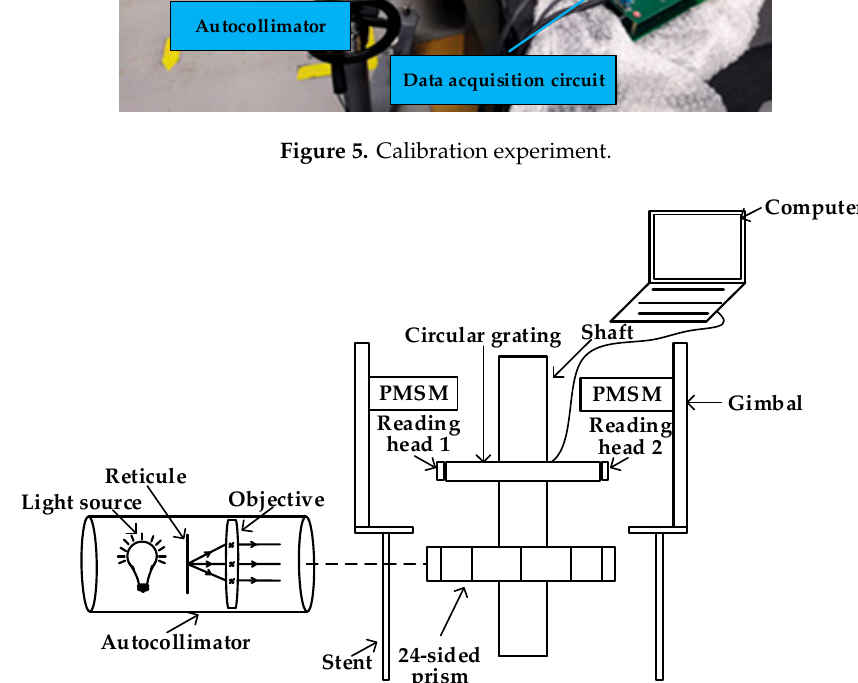
Figure 6. The schematic diagram of the calibration.